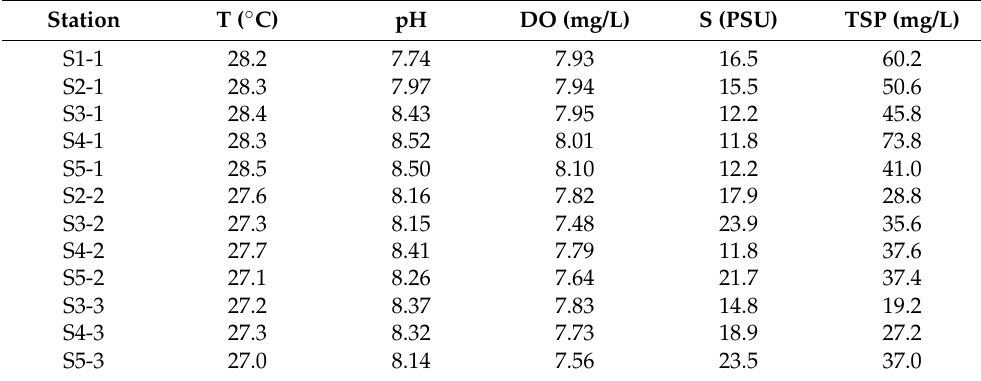
Table 1. Environmental condition of coastal water during the spring algal bloom